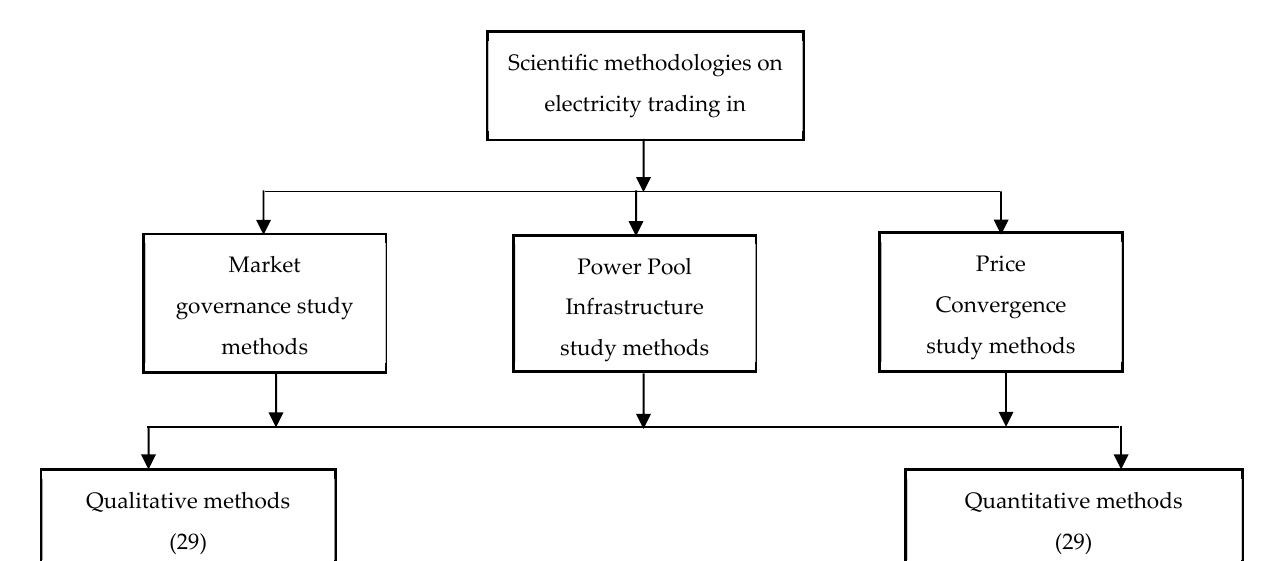
Figure 4. Review strategy of the various methods used in electricity trade in integrated market stud- ies.